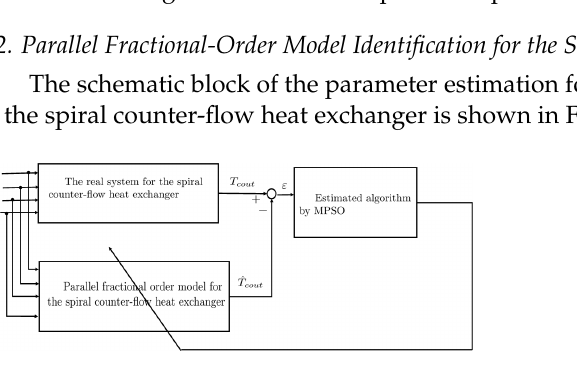
Figure 3. The schematic block of parameter estimation for the parallel fractional-order model of the spiral counter-flow heat